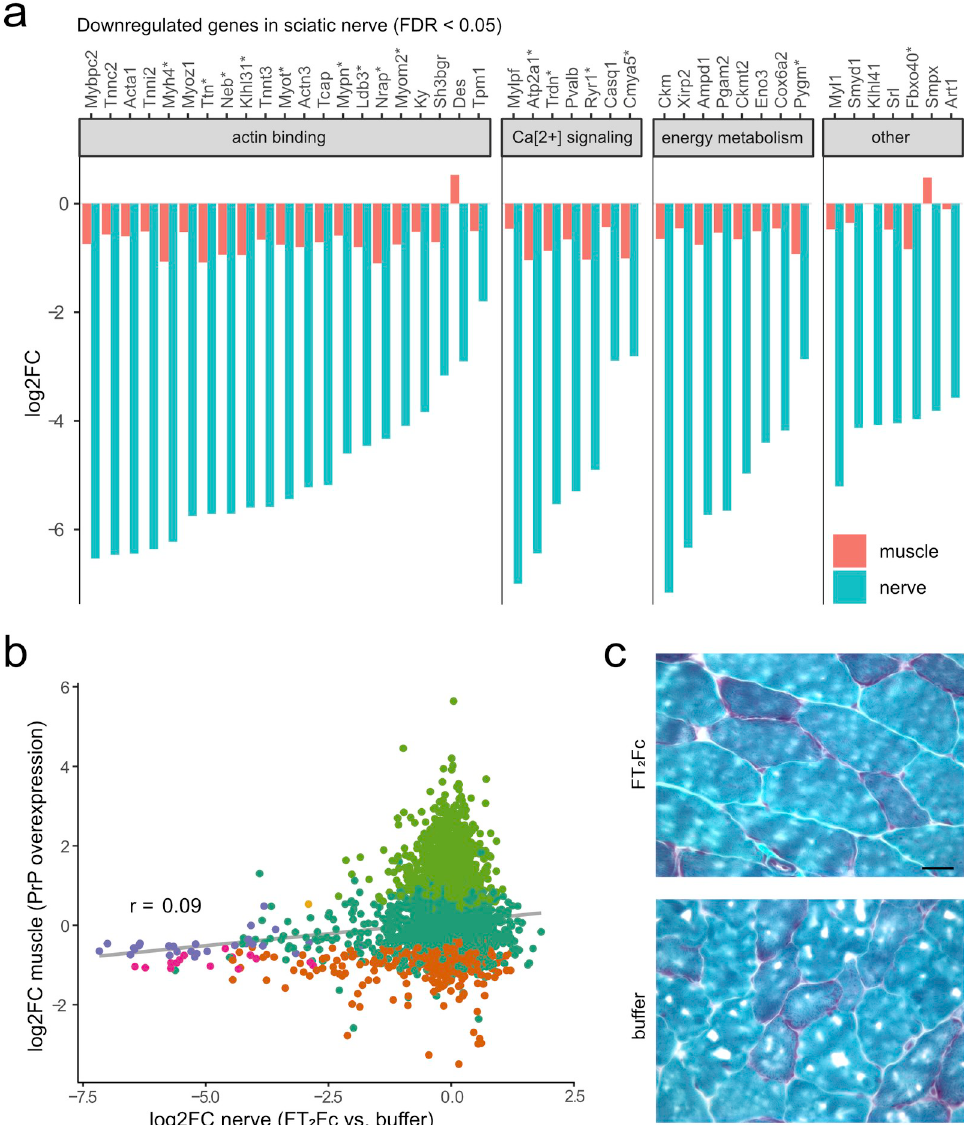
Fig 7. Genes downregulated by FT 2 Fc show similar changes in PrP-overexpressing muscle. (a) Log2 fold change (log2FC) for significantly downregulated genes ( n = 43, based FDR < 0.05) in sciatic nerves of FT 2 Fc treated compared to buffer treated mice and corresponding log2FC in tibialis anterior muscle of PrP overexpressing mice. � marks genes which were also significantly downregulated in muscle based on FDR < 0.05 ( n = 15). Grouping of genes according to common functions was based on a manual search in the UniProt database. (b) Scatterplot comparing gene expression changes in muscle of PrP overexpressing mice and sciatic nerves of FT 2 Fc treated mice. 1229 and 43 genes were significantly (FDR < 0.05) downregulated in muscle and nerve, respectively, with 15 of these genes overlapping. Grey line represents linear regression. Pearson’s correlation coefficient r = 0.09. (c) 10 μ M Gomori trichrome stained frozen sections of gastrocnemius muscle from FT 2 Fc and buffer treated ZH3 mice. Muscle fibre morphology was similar in buffer and FT 2 Fc treated mice. No myopathic changes were detected in FT 2 Fc treated mice. Scale bar 20 μ M. FT Fc treatment. We wondered whether this may have been caused by disadvantageous phar- 2 macokinetic properties of FT Fc. We detected FT Fc in sciatic nerve lysate by western blotting, 2 2 but this did not allow us to conclude that FT Fc reached Adgrg6 on Schwann cells. It is possible 2 that, as a relatively large molecule, FT Fc might not have reached Adgrg6 in sufficient 2